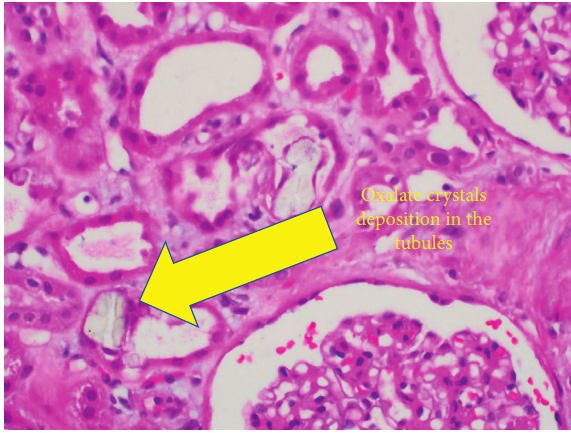
Figure 2: Oxalate crystals seen again in the kidney